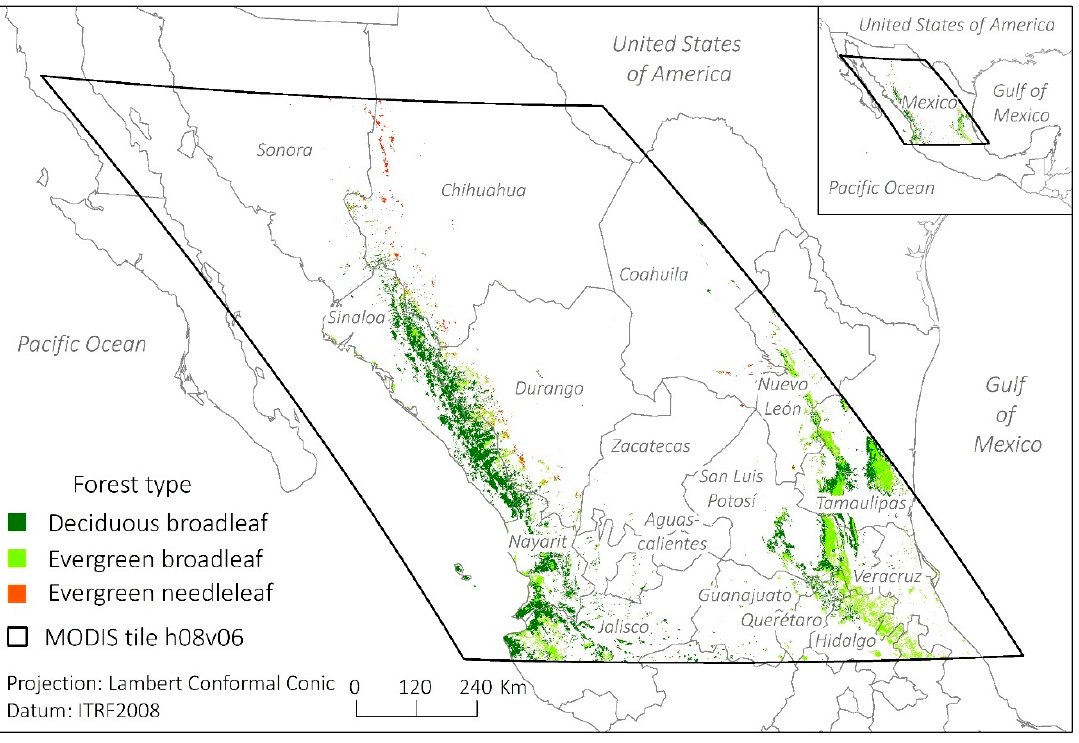
Figure 1. Study area: pixels covered by forest during at least one year between 2002 and 2017. Moderate Resolution Imaging